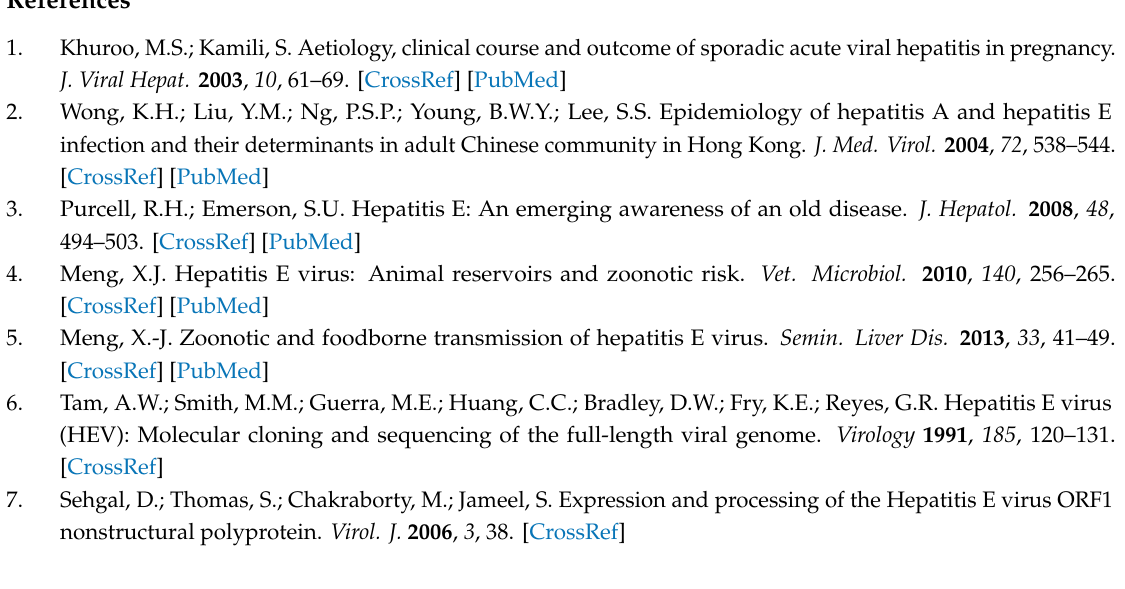
Figure S1: Capture ELISA for the HEV ORF2 protein quantification (a) Standard curve with purified rHEV ORF2 protein. The y-axis is the absorbance value. The x-axis is the value of rHEV ORF2 protein. (b) The expression level of chimeric M2 HEV and HEV ORF2 in TSP extracted from fresh plant leaves inoculated with the relevant constructs. Figure S2: Western blot with anti-HEV ORF2 mAb of the constructs; (a) HEV 110–6101; (b) HEV 33–660; (c) HEV 1–610; (d) HEV 33–610; M. Molecular weight marker (kDa); 1. pEAQ- HT empty vector; 2. Crude extract; 3. SN (soluble protein) after extraction in 3x volume and 13k rpm; 4. Pellet (insoluble part); 5. Positive control (HEV ORF2 452–617 aa recombinant protein). Figure S3: SDS-PAGE (a) and Western blot with anti-HEV ORF2 mAb (b) of TSP extracts (1 mg FW) of HEV chimeric constructs bearing M2e peptide and its relevant HEV construct without M2e; M. Molecular weight marker (kDa); 1. Healthy plant; 2. Empty pEAQ- HT ; 3. M2 HEV 1–610; 4. HEV 1–610; 5. M2 HEV 33–610; 6. HEV 33–610; 7. M2 HEV 110–610; 8. HEV 110–610. Figure S4: TEM